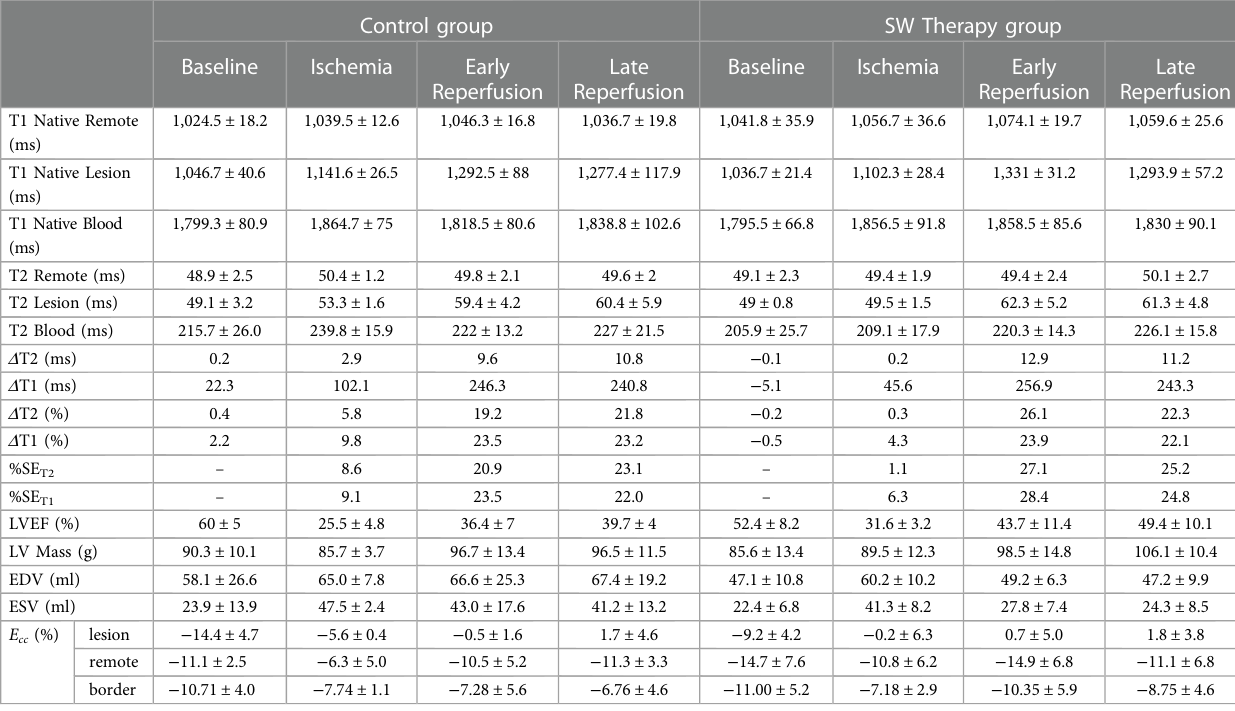
TABLE 1 Main MR derived parameters obtained in control and intervention (SW therapy) groups, at the main stages of the